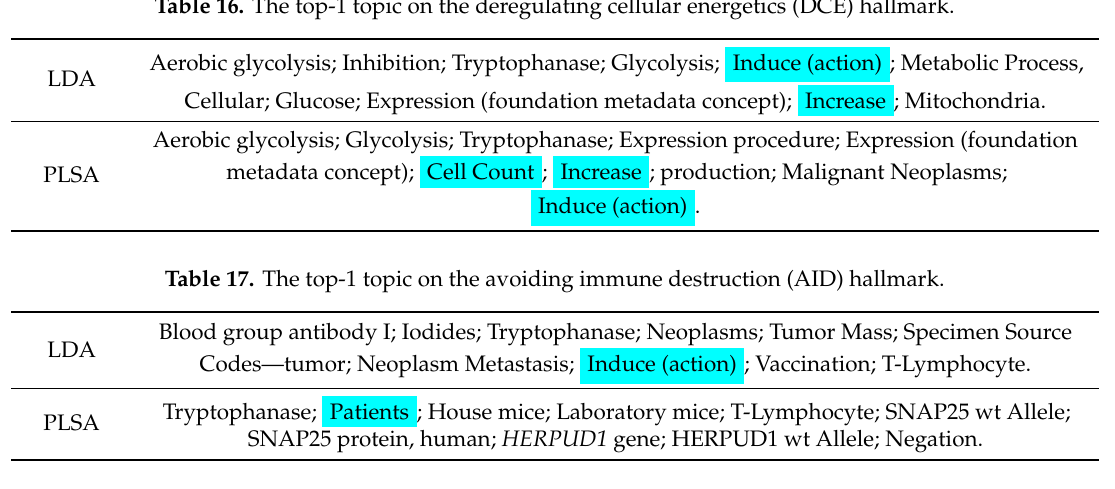
Table 16. The top-1 topic on the deregulating cellular energetics (DCE) hallmark.